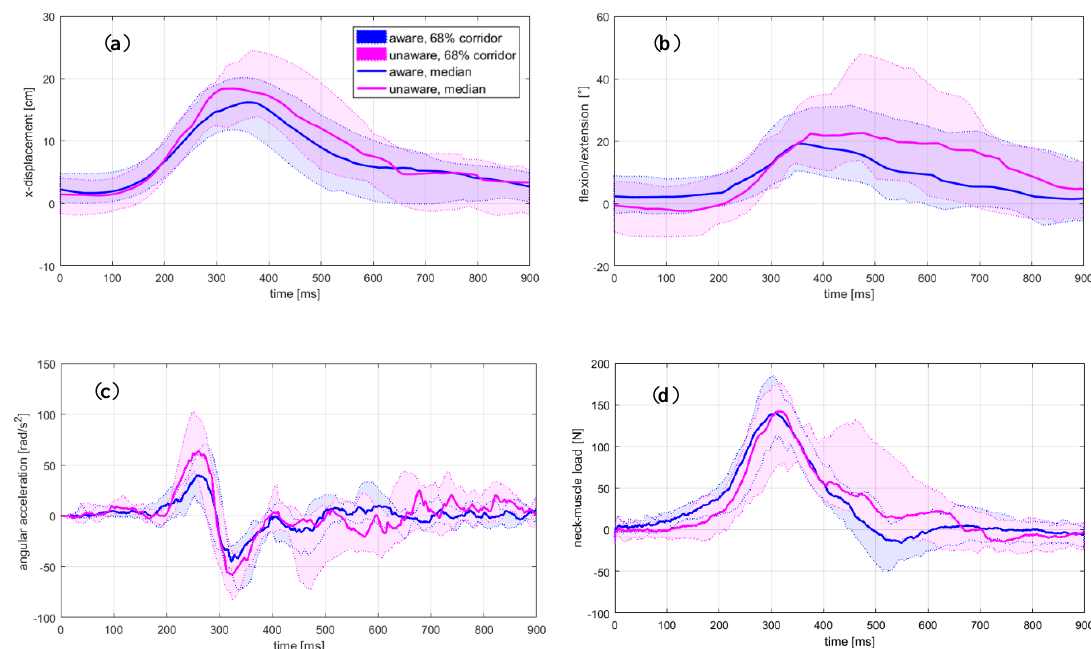
Figure 2. Head-neck′s motion from motion-capture and inverse dynamics analyses: ( a ) horizontal excursion, ( b ) flexion, ( c ) angular acceleration; ( d ) estimated load for the neck′s extensor muscles.